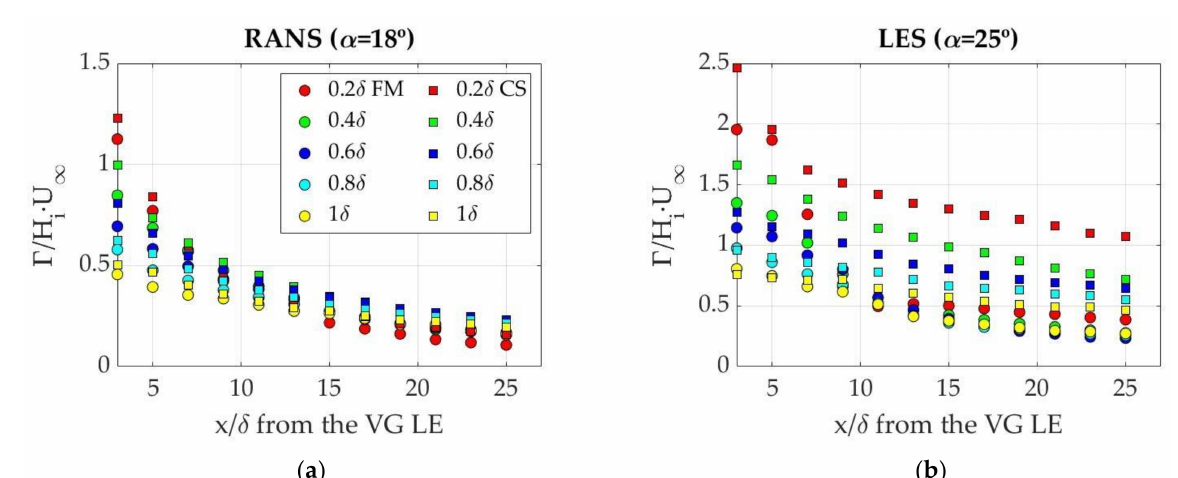
Figure 12. Vortex circulation normalized with the VG height and the flow streamwise velocity. ( a ) RANS and ( b )